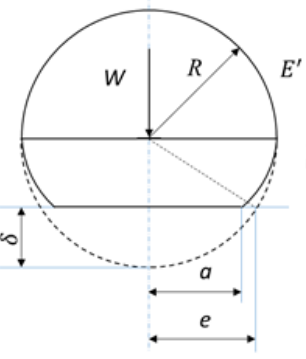
Figure 3. Unimodal elastic contact.